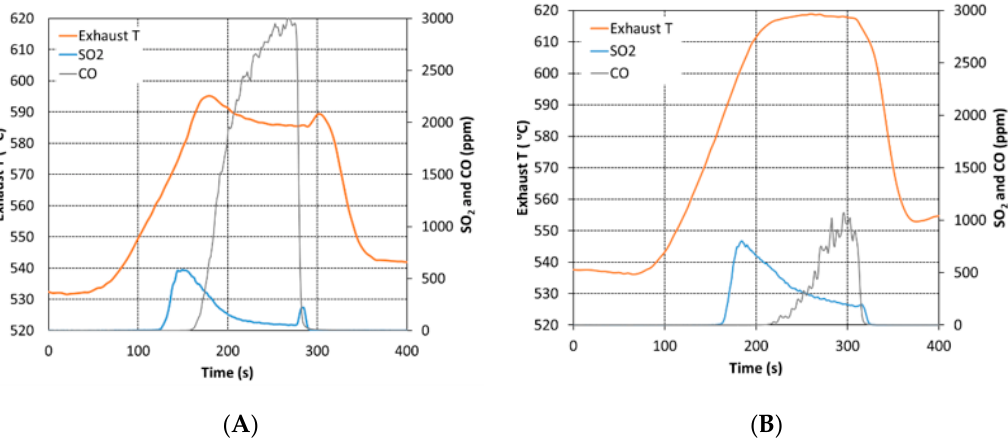
Figure 5. Exhaust temperature downstream the MOC. SO 2 and CO downstream the MOC during the regeneration phase. ( A ) the case of “trap + MOC” for 1 st and 3 rd regenerations ( B ) the case of “trap + MOC” for 4 th regeneration.